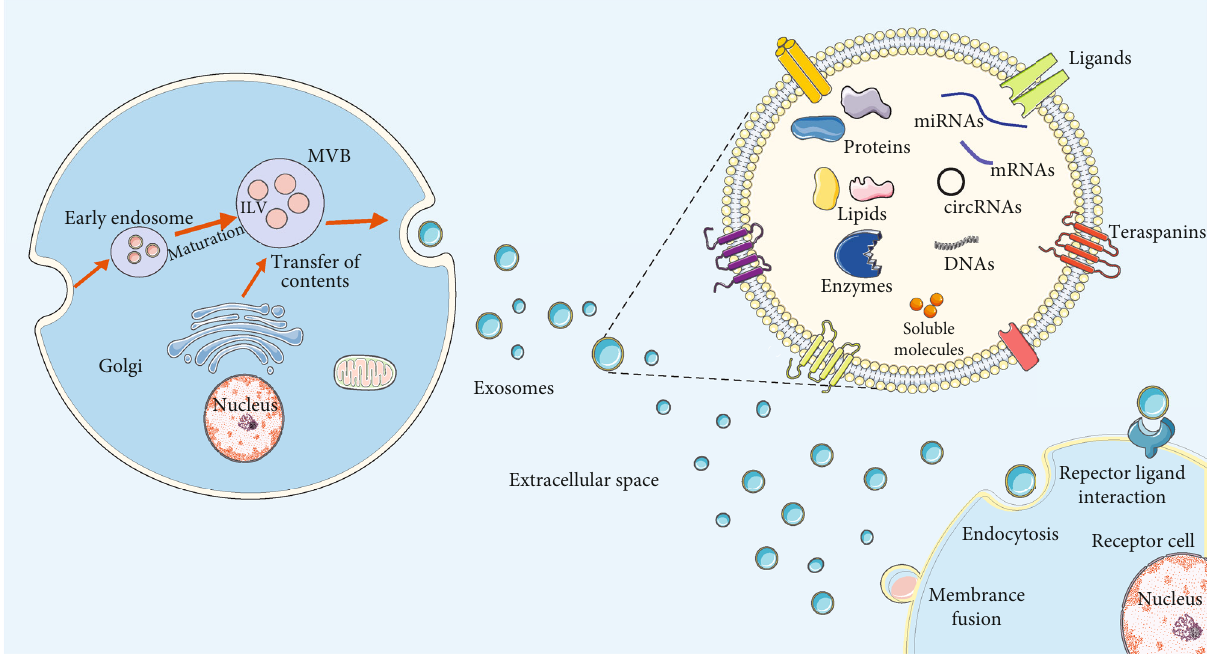
Figure 1: Exosome biogenesis and uptake. Exosomes are generated by the endosomal pathway and released to the extracellular space. Cellular contents, such as proteins, lipids, metabolites, small molecules, DNA, and RNA, along with cell surface proteins can enter exosomes through endocytosis and plasma membrane invagination. Exosomes released by a donor cell can elicit biological responses in a receptor cell by interacting with cell surface proteins or receptors or after being internalized by endocytosis or through membrane